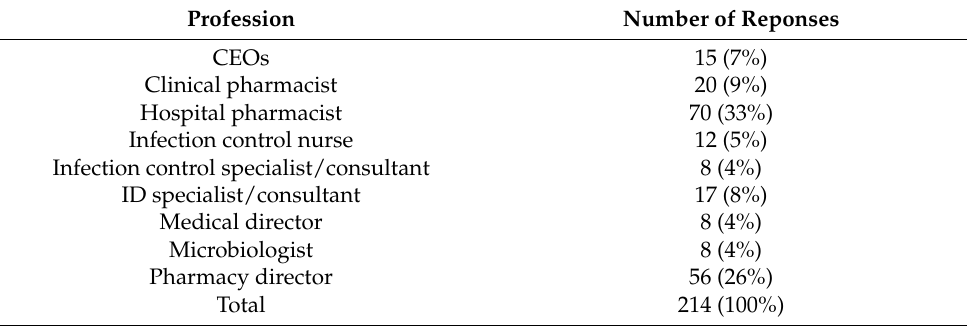
Table 1. Survey respondents per